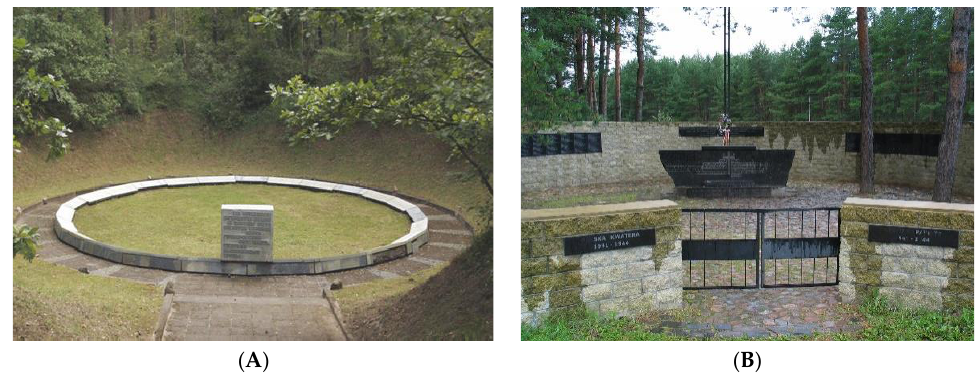
Figure 9. ( A ) Paneriai Memorial in Vilnius, Lithuania. Available online: https://tinyurl.com/bzw2 uzuh; https://tinyurl.com/25y752kt (accessed 22 March 2022); ( B ) Paneriai Memorial in Vilnius, Lithuania. Available online: https://tinyurl.com/bzw2uzuh; https://tinyurl.com/25y752kt (ac- cessed 22 March